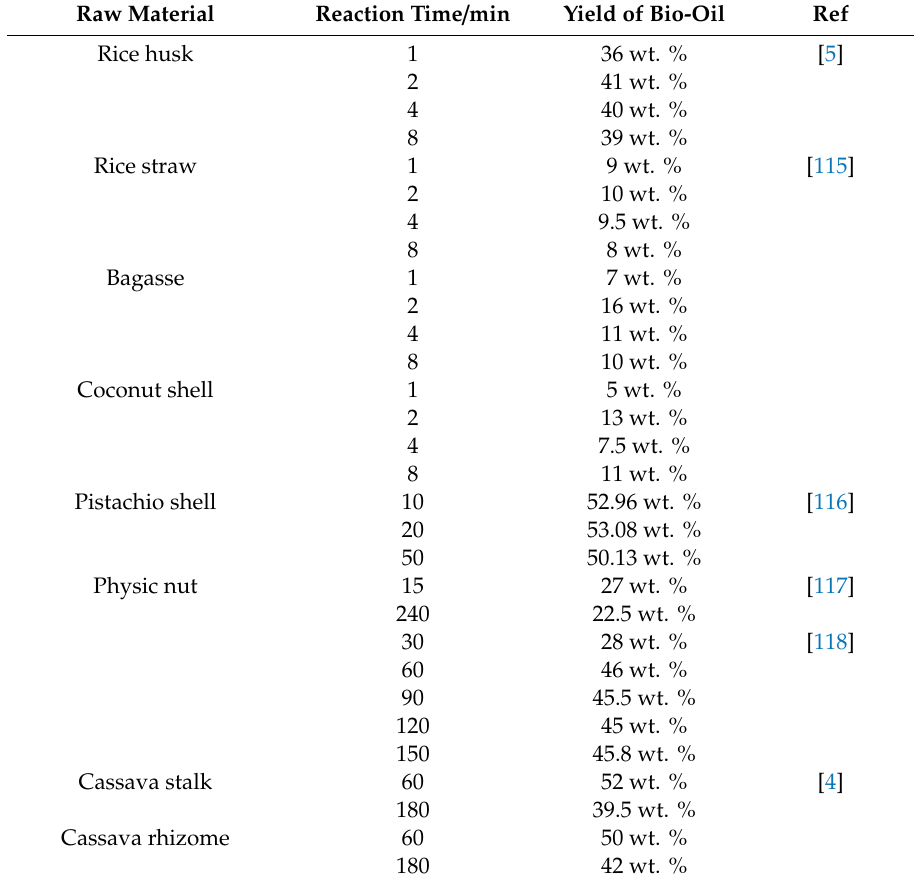
Table 4. Suitable reaction time for di ff erent